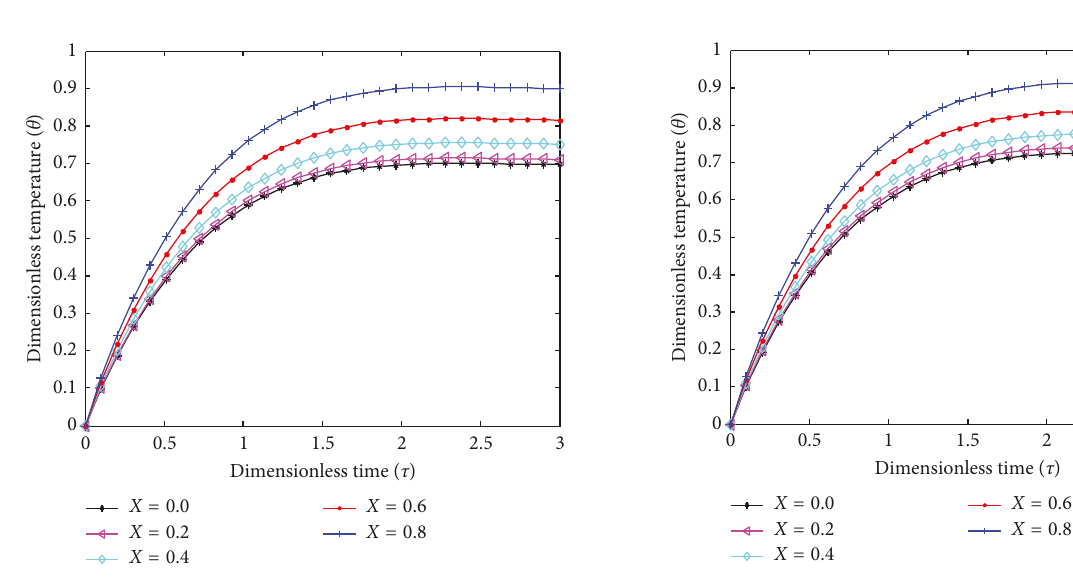
Figure 3: Temperature history in the fin at various locations when the thermal conductivity varies according to quadratic-law function.